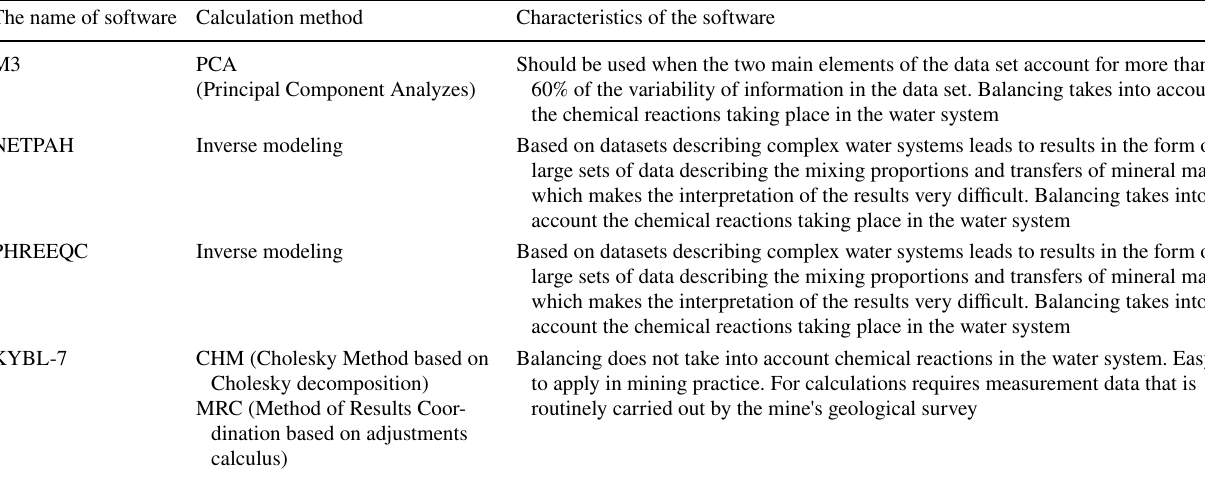
Table 1 Brief characteristics of all computer programs mentioned in this article that can be used for balancing mine water systems The name of software Calculation